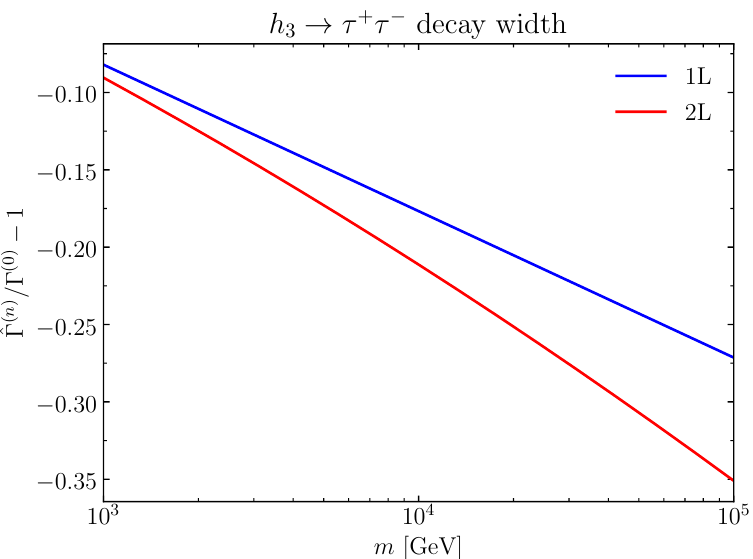
Figure 14. One-loop and two-loop external leg corrections to the h 3 → τ + τ − decay width in the N2HDM relative to the tree-level result as a function of the heavy mass scale m (see text). The input values in this plot are (cid:15) = (50 GeV ) 2 , tan β = 1 . 26 , s α